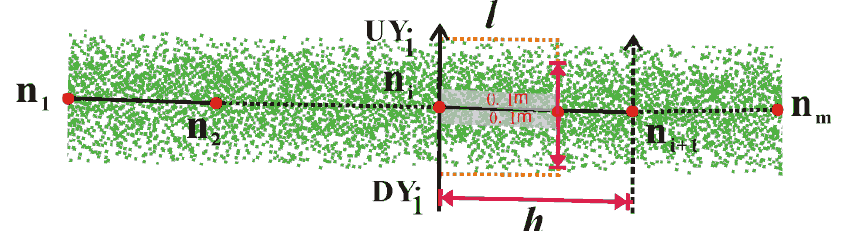
Figure 5. The detection of trajectories strip